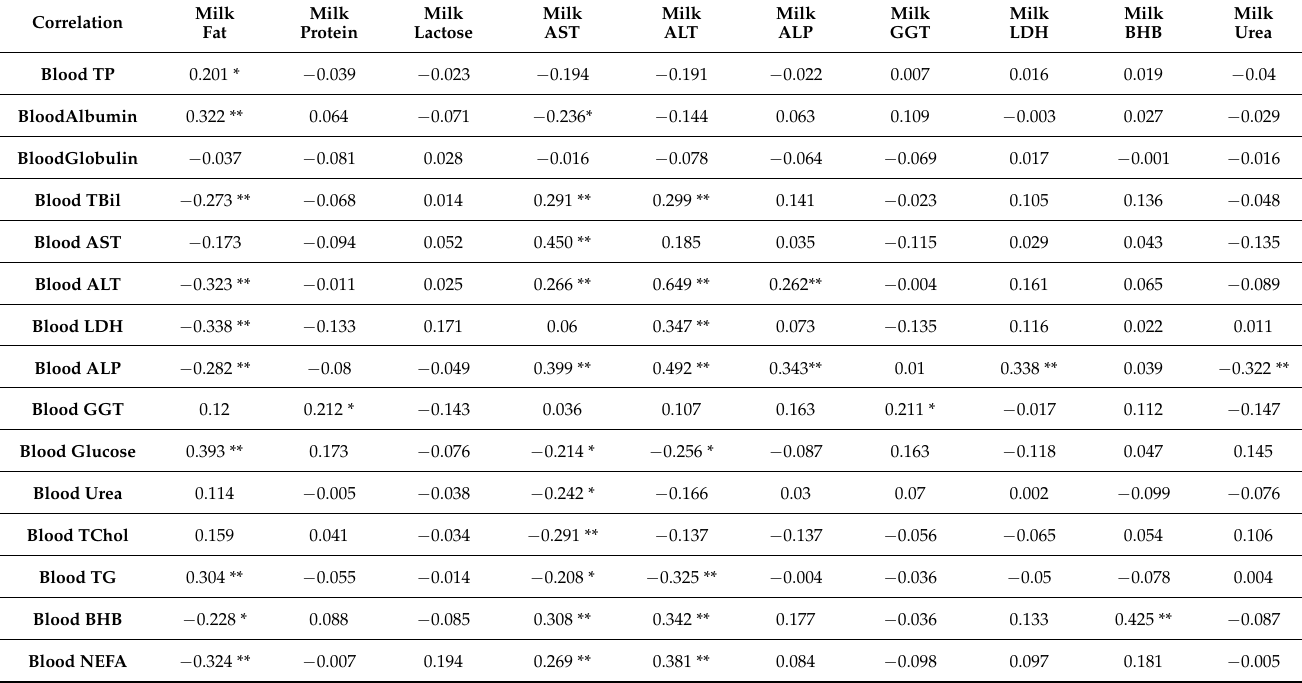
Table 3. Correlation between milk composition and diagnostic blood metabolic parameters.